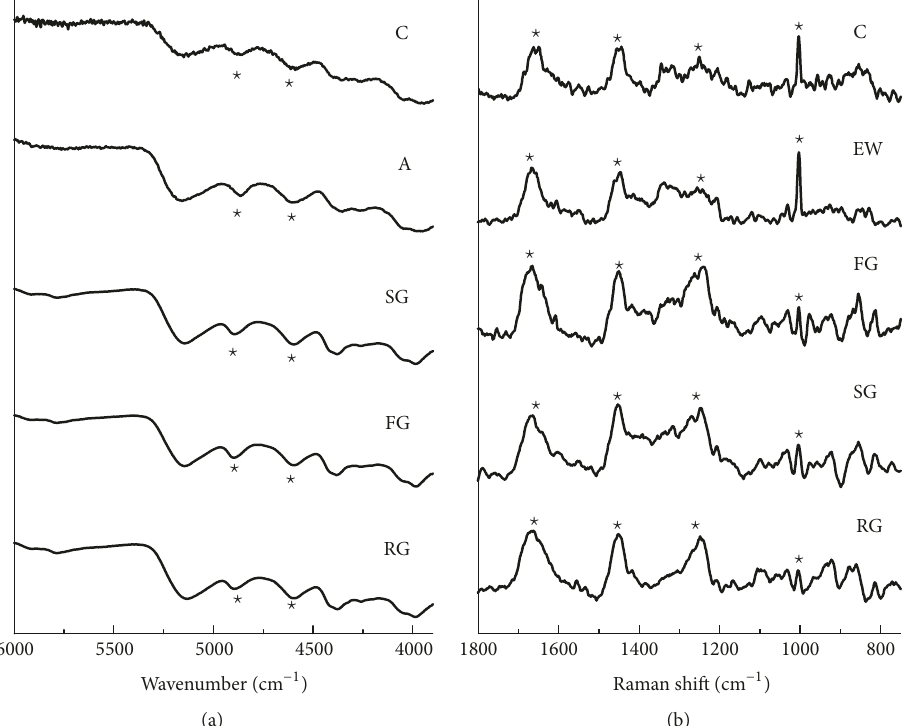
Figure 1: FT-NIR (a) and Raman (b) spectra of casein-C, egg white-EW, fish glue-FG, strong glue-SG, and rabbit glue-RG. Raman spectra are presented after background subtraction. Star symbols point to some specific spectral features discussed in the text. The assignments of the FT- NIR and Raman spectra are reported in Tables S1 and S2 in Supplementary Material available online at https://doi.org/10.1155/2017/3475659.